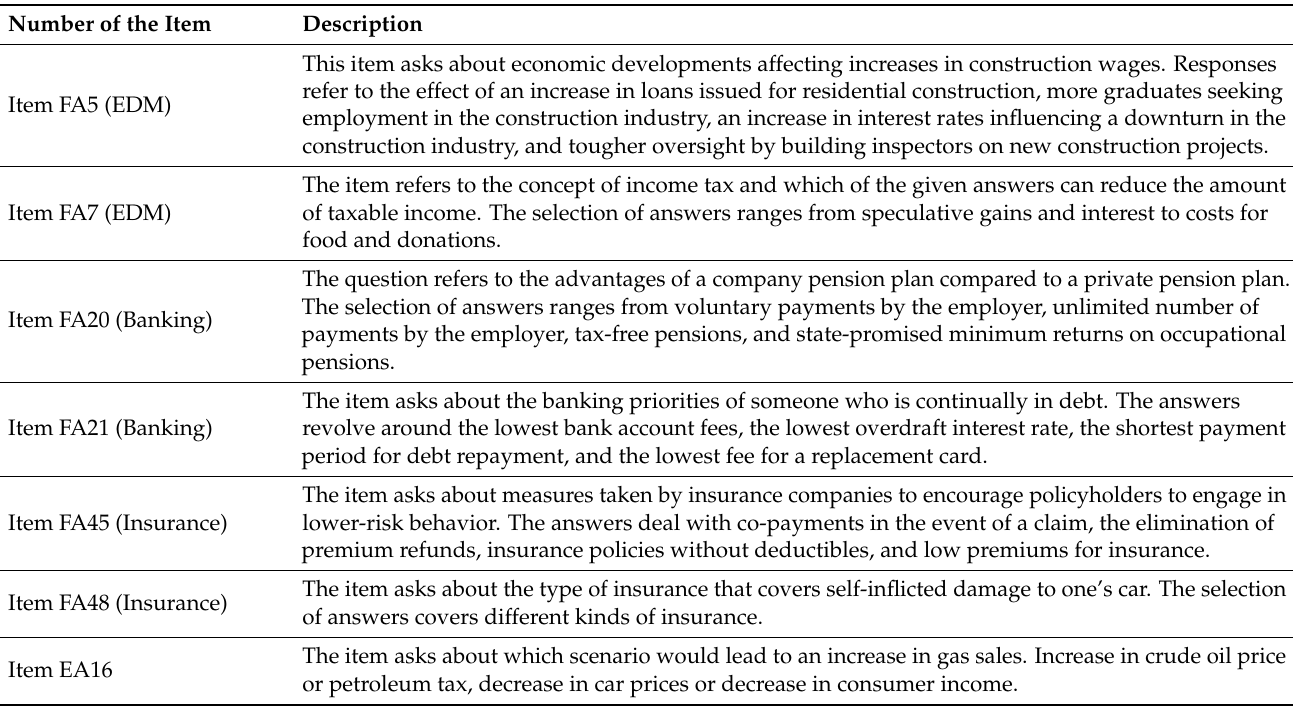
Table A2. Description of the